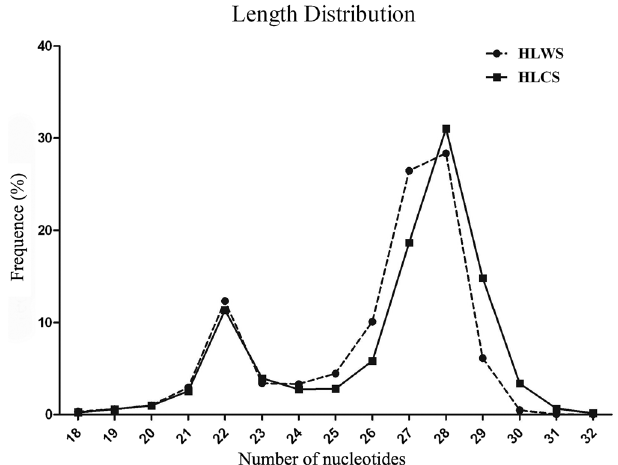
Figure 1. Length distribution and abundance of sequences in HLWS and HLCS. Sequence length distribution of clean reads based on abundance levels and distinct sequences. The most abundant size class was 28 nt, followed by 22 nt. The X -axis indicates the lengths of small RNAs; the Y -axis indicates the percent frequency